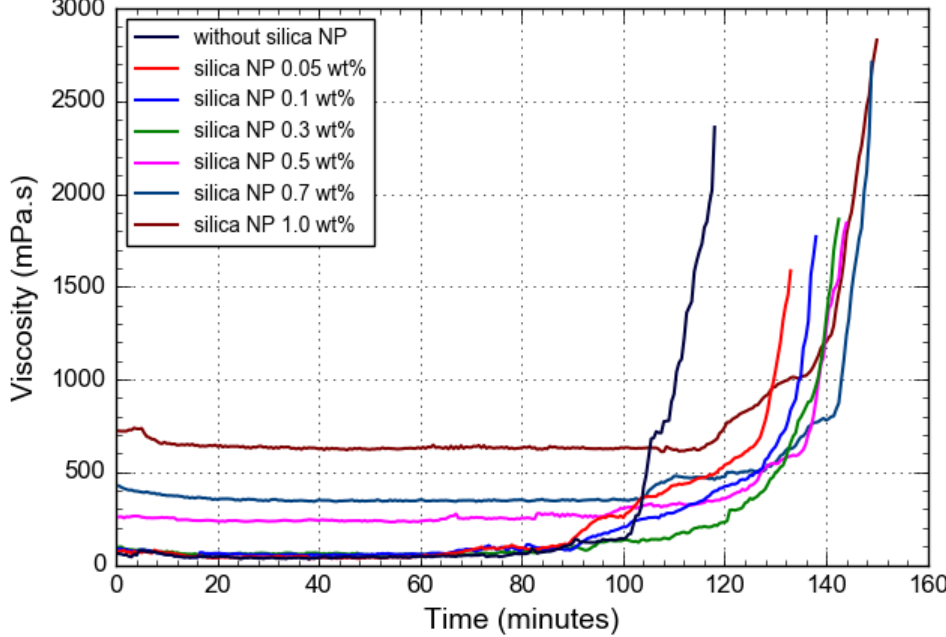
Figure 6. Viscosity changes as a function of time for PAM/PEI polymer gel with different concentra- tions of silica NP.